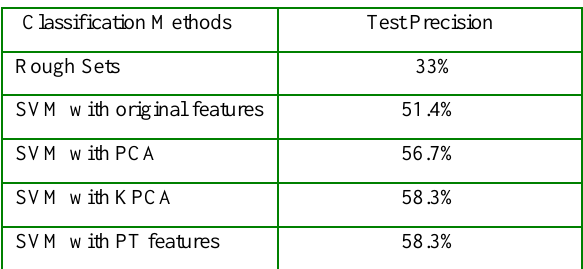
Table 3. Performance Comparison among different